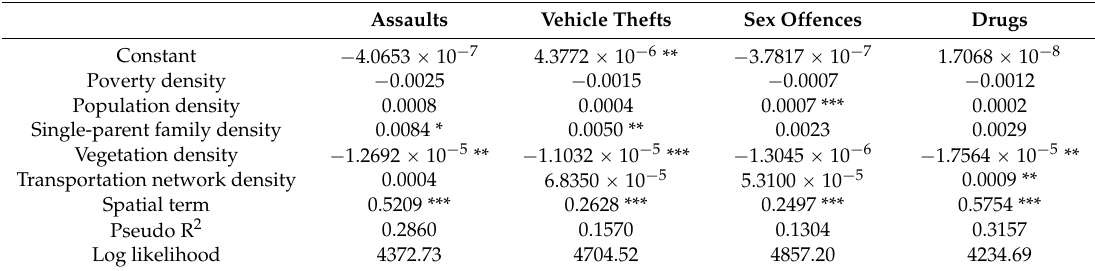
Table 5. Spatial regression results for assaults, vehicle thefts, sex offences, and drugs.